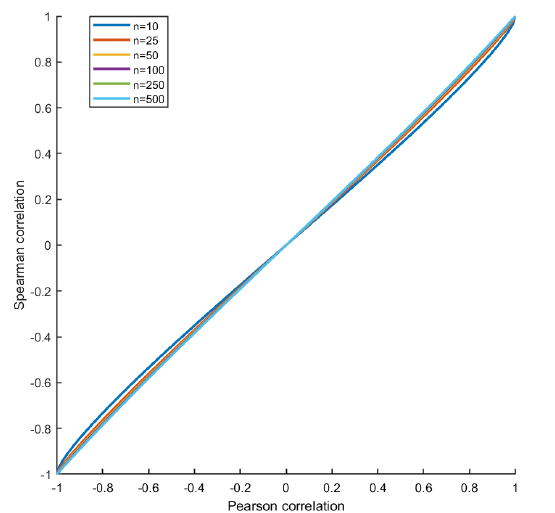
Figure 10. Relationship (see Equation (5)) between the Spearman’s (Equation (7)) and the Pearson’s (Equation (6)) correlation coefficients for linearly correlated data for different sample size n